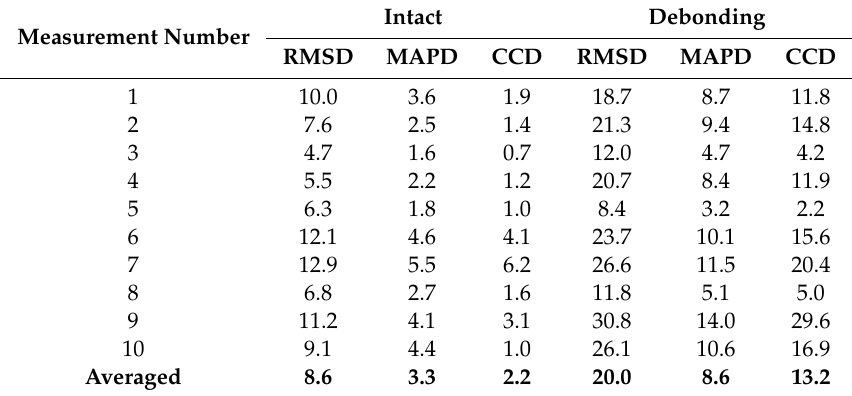
Table 3. Results for 0.6 mm thickness top composite